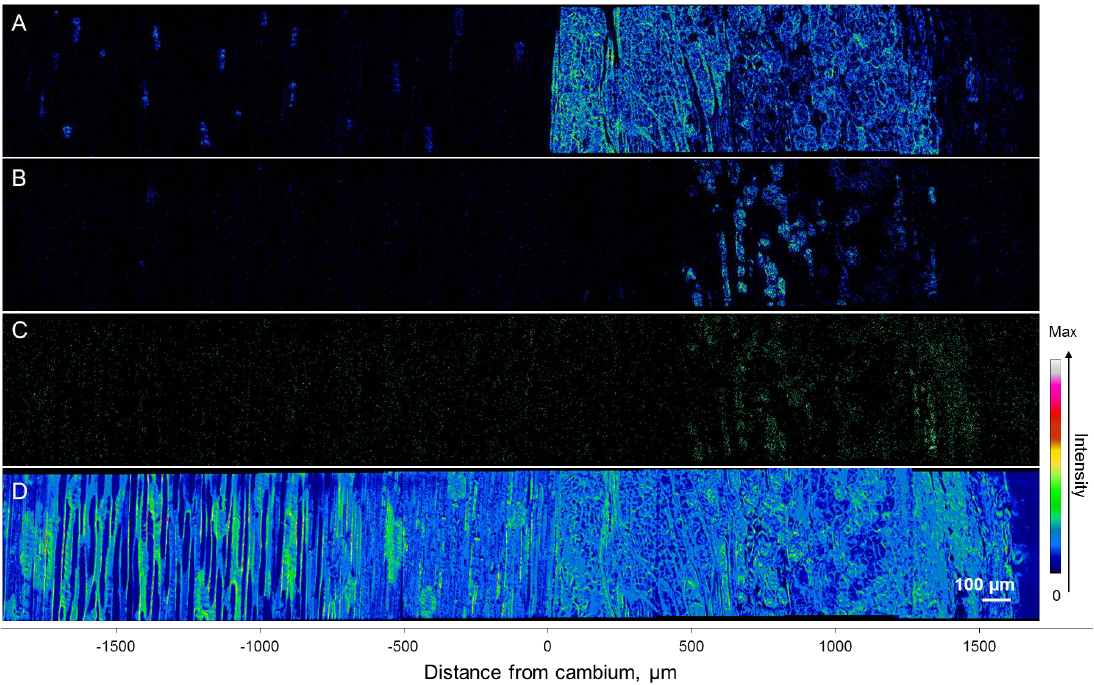
Figure 10. Positive ToF-SIMS images at the tangential-radial surface of wounded Norway spruce phloem from the xylem (on left) to the outer bark (on right) at different distance from the cambium (µm) The specimen location is 4 mm upwards from the wounding site on the sapling stem. Secondary ions at m / z 184 (A), 245 ( B ), and 291 ( C ) represent the membranes of living cells, stilbene glucoside astringin, and (+) − catechin, respectively. The total secondary ions ( D ) represent the tissue structures. The color of the pixels corresponds to the ion intensities of the compounds on the specimen surface. Specifically, (+) − catechin and stilbene glucosides were absent from dark areas, showed mid-range concentrations in blue areas, and had the highest concentrations in green and yellow areas. K areas showed mid-range concentrations in blue areas, had the highest concentrations in green and yellow areas.